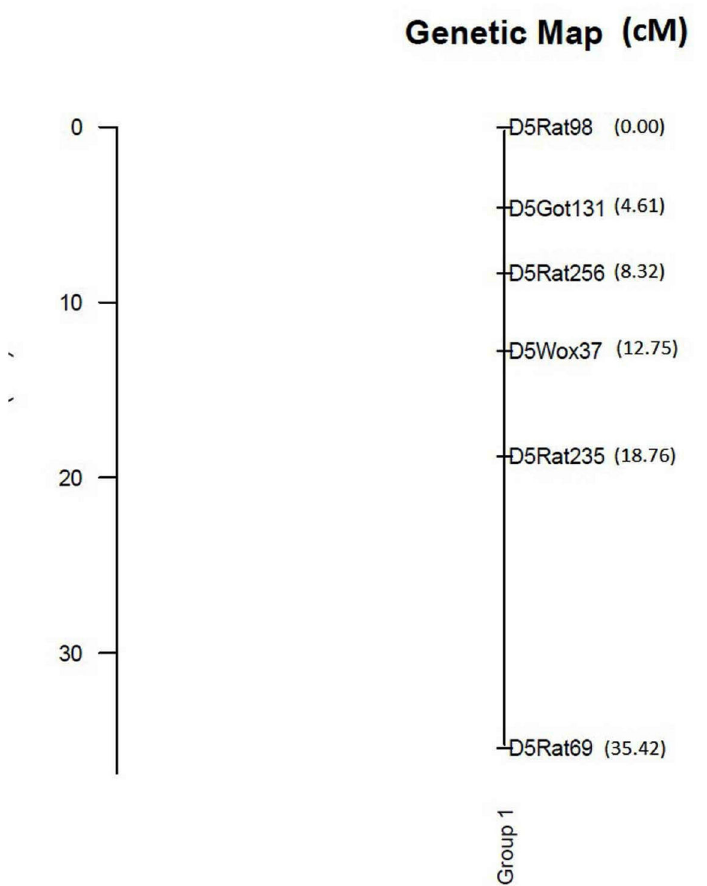
Figure 2. Genetic map distances (cM) were estimated between the markers using F doi: